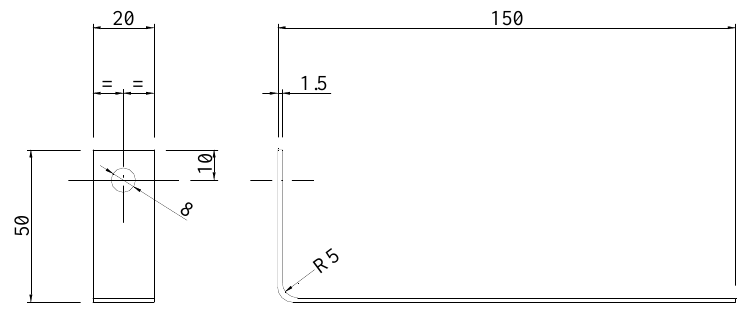
Figure 2: Outline of half of the 1.5mm-thick T-peel joint tested in